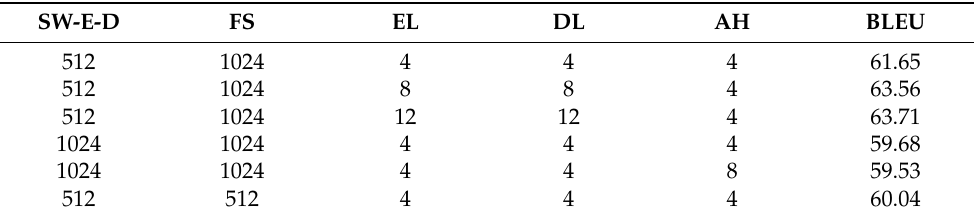
Table 1. Results of the Transformer-Based NMT Subword Model on PMM-LEV corpus for LEV–MSA translation task, where SW-E-D is the Subword embedding dimension, FS is the filter size, EL is the encoder layer, DL is the decoder layer and AH is the attention heads number.